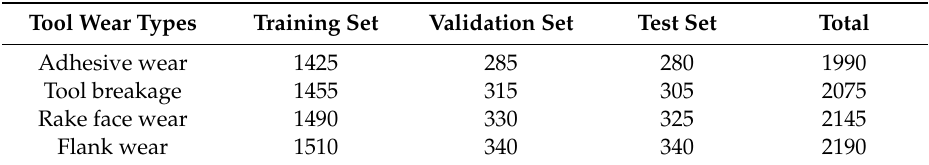
Table 5. Statistics of the tool wear image